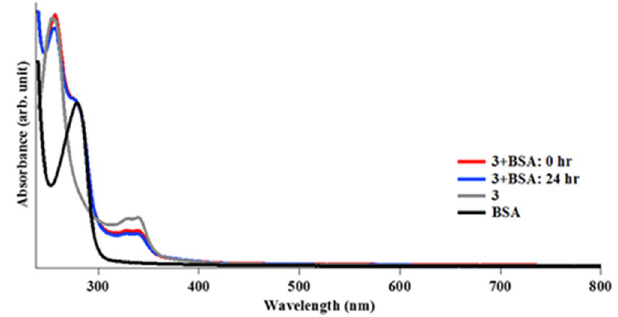
Figure 7. UV-Vis absorption spectra of 3 , BSA, and 3 and BSA mixture in PBS. Concentration of complex 3 and BSA = 25 μ M. DMSO was used for stock solution of 3